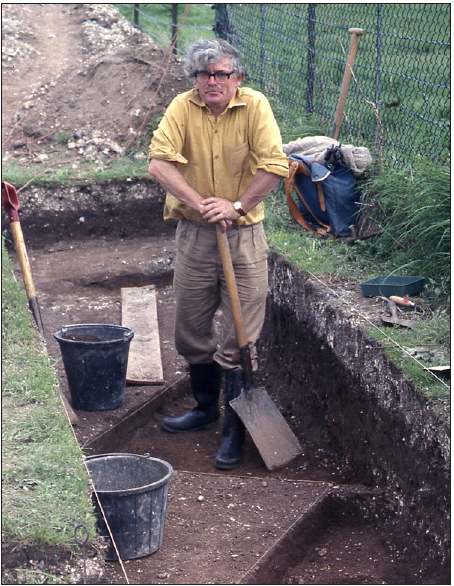
Figure 2: Arthur ApSimon excavating at Stonehenge (Photo: Mike Pitts).